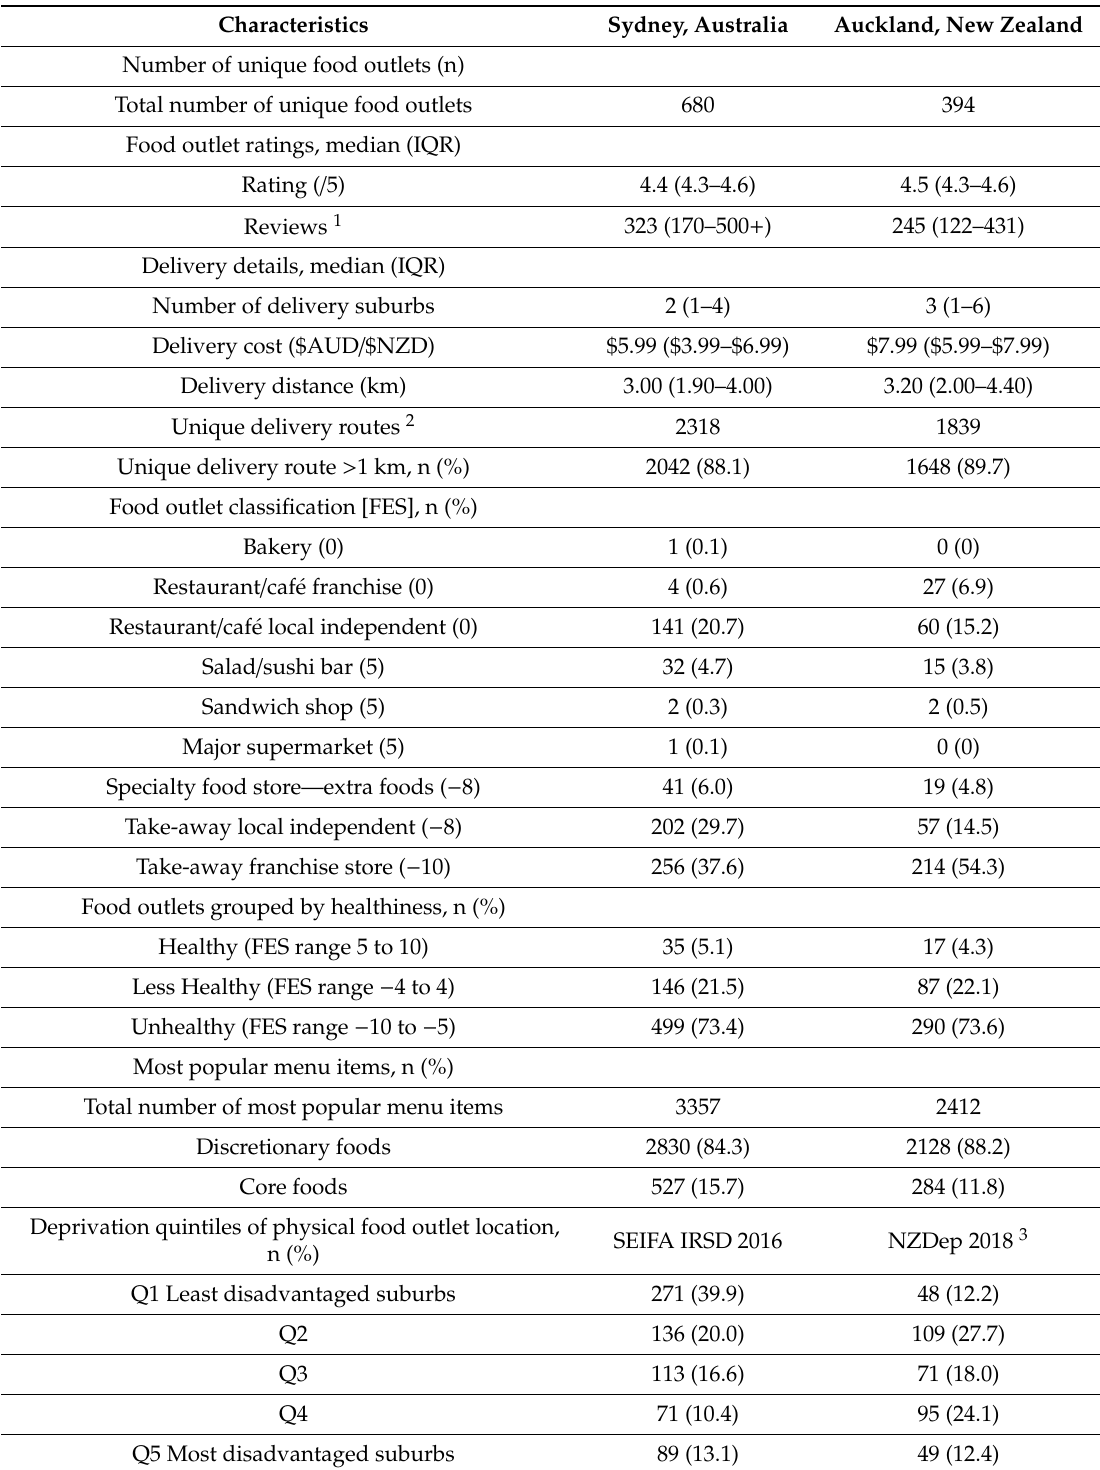
Table 2. Characteristics of food outlets, the healthiness of food outlets and nutritional qualities of most popular menu items available on Uber Eats in Sydney, Australia and Auckland, New